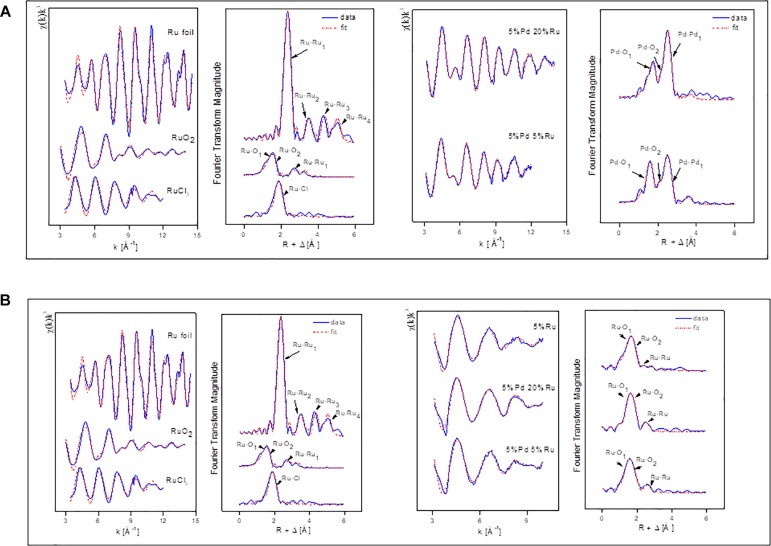
(A) EXAFS spectra of Pd foil and Pd-Ru biogenic NPs samples as well as their corresponding FT. (B) EXAFS spectra of Ru foil, RuCl3, and Pd-Ru biogenic NPs samples as well as their corresponding FT.